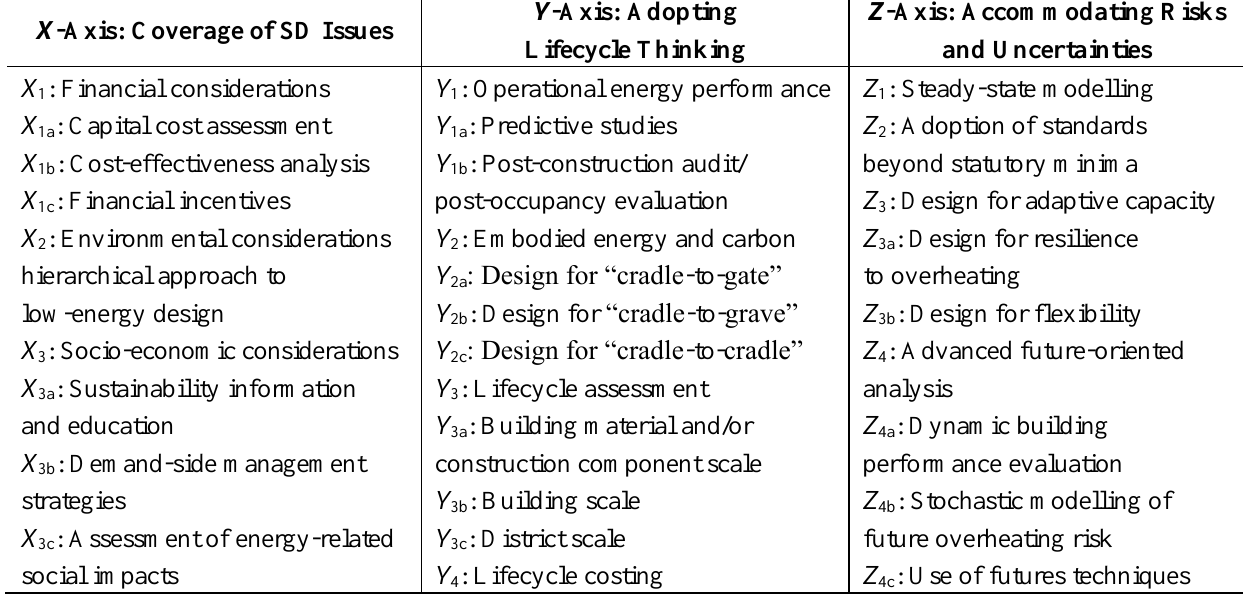
Table 2. Categorisation of future-proofed design approaches. Adapted from